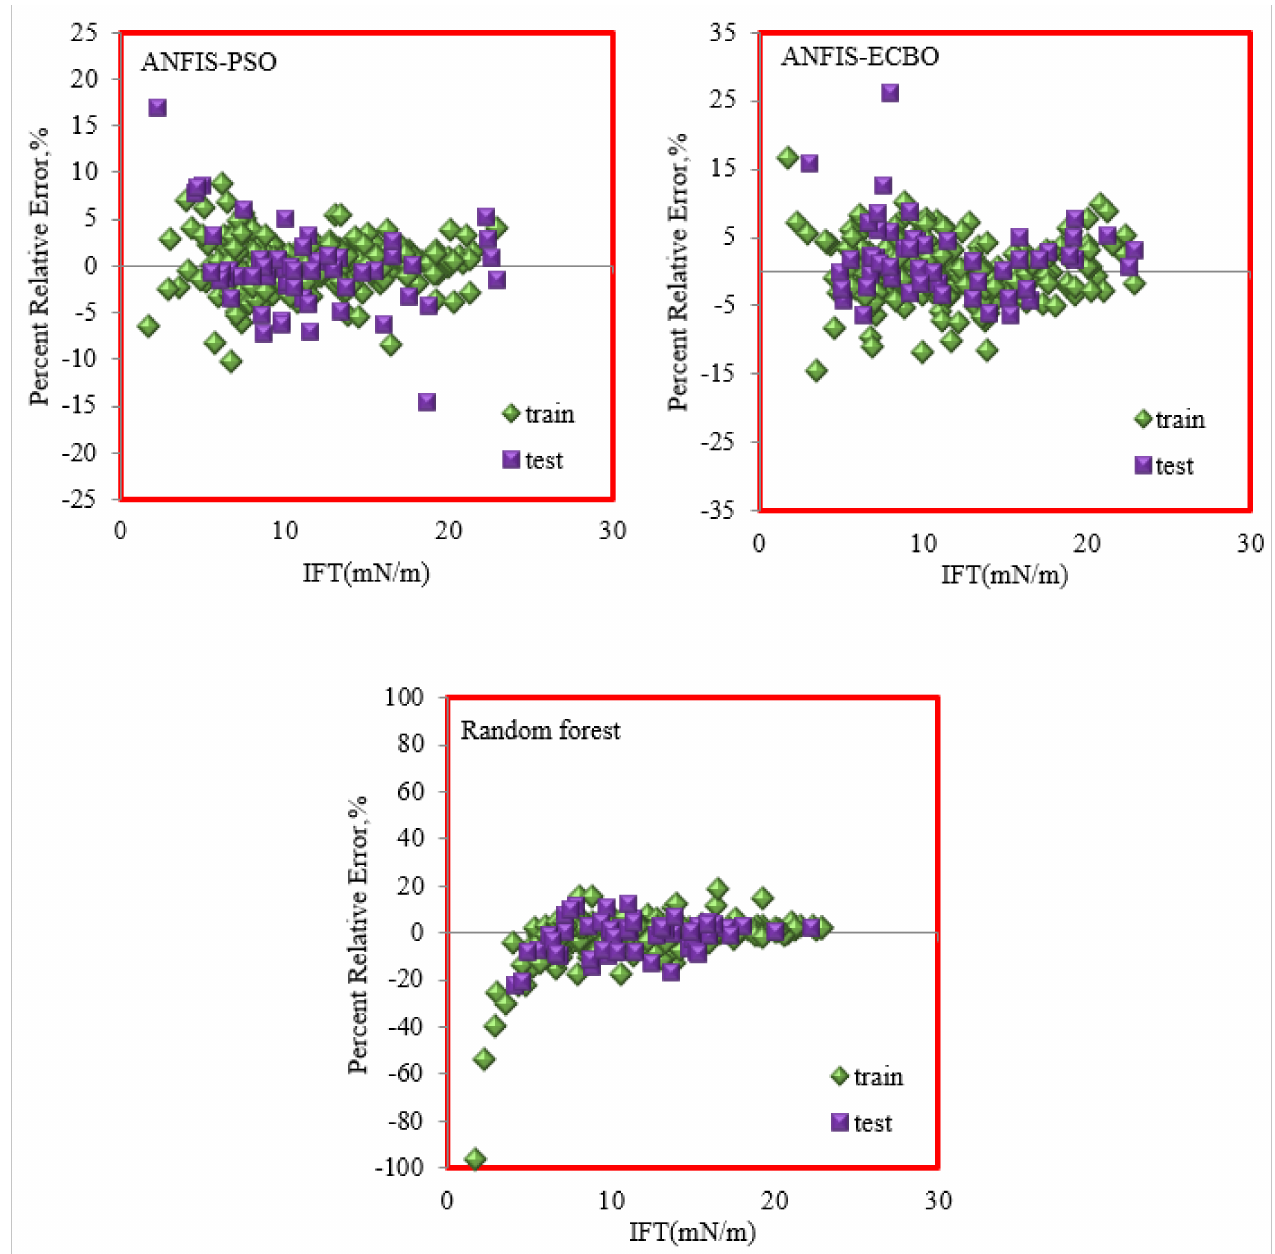
Figure 7. Error distribution graphs of the implemented models (percent relative error vs. experimental IFT